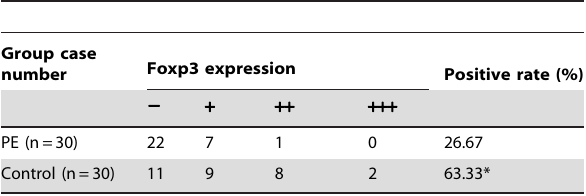
Table 2. Foxp3 expression levels in decidual and trophoblast cells between PE and control groups.